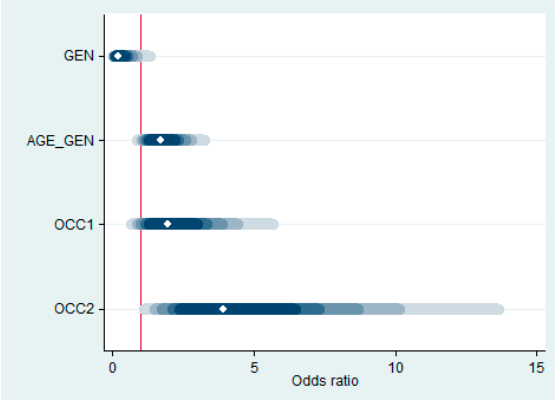
Figure A1. Plots of statistically significant variables from model (3) estimation. Confidence intervals: 99% = dark blue; 95% = mild blue; 90% = light blue.